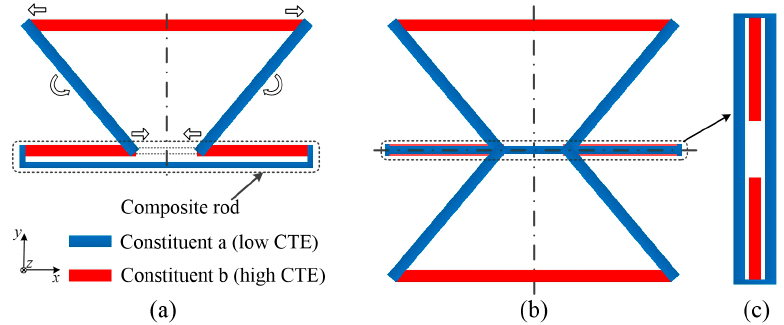
Figure 3. Schematic illustration of bi-material negative thermal expansion (NTE) inverted trapezoid lattices (ITLs). ( a ) Single ITL of anisotropic NTE. Constituent ‘a’ forms the hypotenuse, Constituent ‘b’ forms the upper base. The base is the composite rod. The two hypotenuses, upper base and the ‘virtual rod’ form an inverted isosceles trapezoid. The arrows show the deformation mechanism of the ITL after heating. ( b ) X-symmetric lattice of anisotropic NTE. The part in the dotted box is the composite rod. The composite rod is located in the xz plane. ( c ) Top view of the composite rod after 90° clockwise rotation.